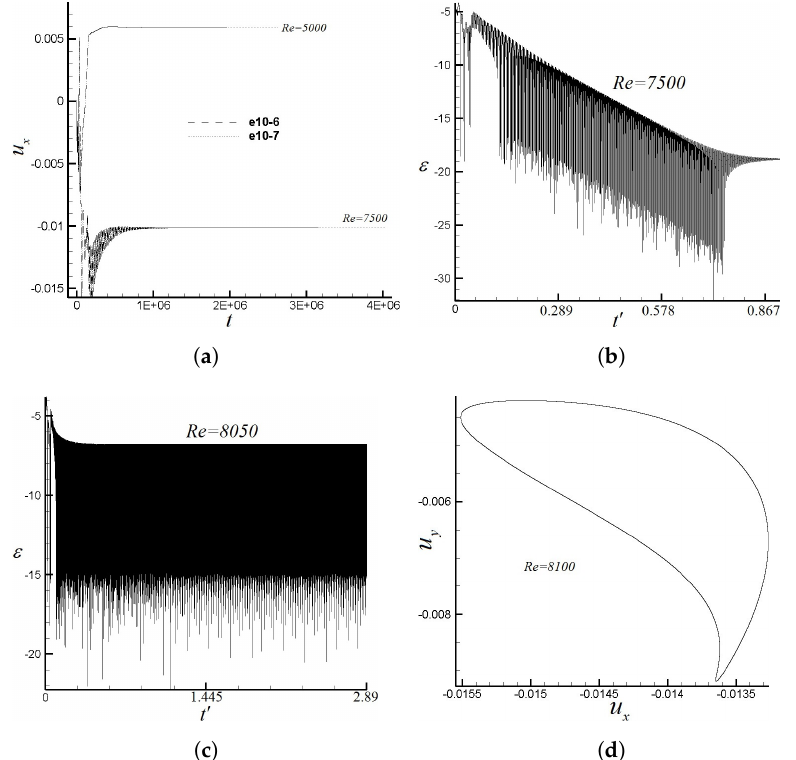
Figure 4. Velocity component u x versus iteration steps t . ( a ) Steady solutions at Re = 5000 and Re = 7500. ( b ) Logarithmic value of perturbation at Re = 7500. ( c ) Logarithmic value of perturbation at Re = 8050. ( d ) Phase map of u x versus u y at a periodic Reynolds number